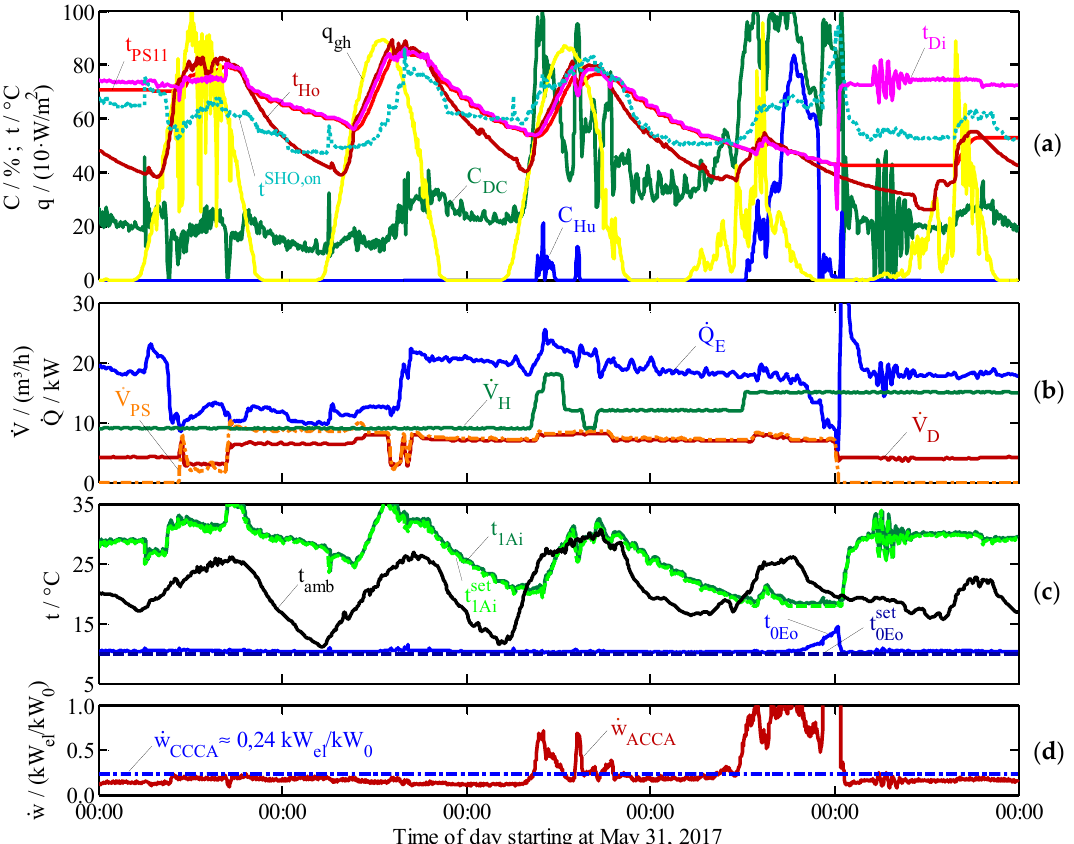
Figure 2. Continuous solar heat operation extending over more than three days during a test period (i.e., without the improved control strategy): ( a ) global horizontal irradiation, q (cid:2917)(cid:2918) , temperatures in the hot water circuit, and control signals from RHD; ( b ) flow rates and cooling capacity; ( c ) ambient air temperature and temperatures in the chilled and cooling water circuit; ( d ) specific electricity demand.